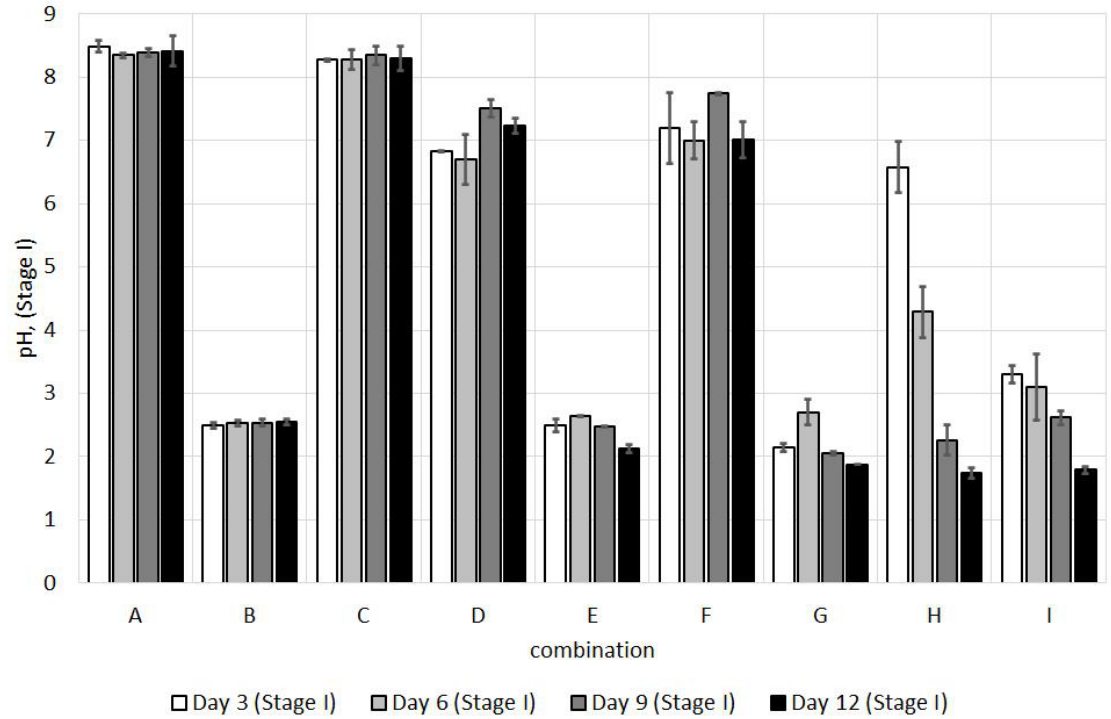
Figure 1. Changes in pH in the combinations tested in Stage I.